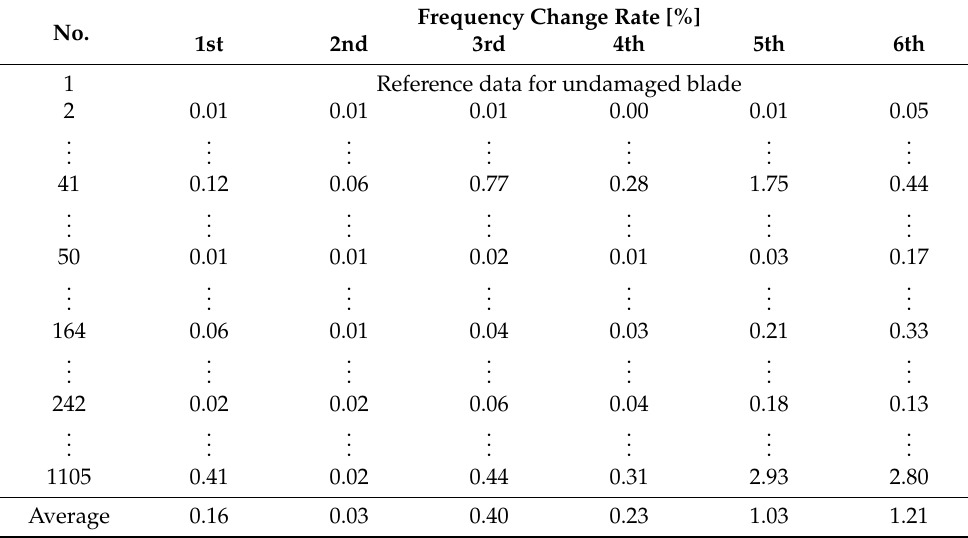
Table 4. Frequency change rates and